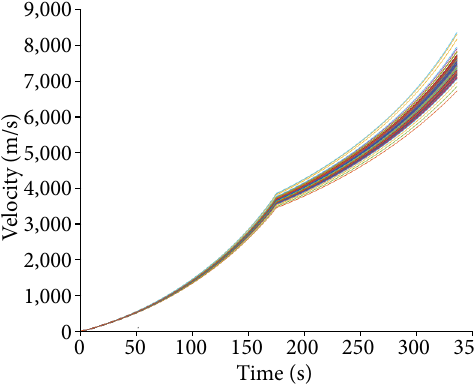
Figure 7. The effect of uncertainties on the SLV final speed with deterministic optimal